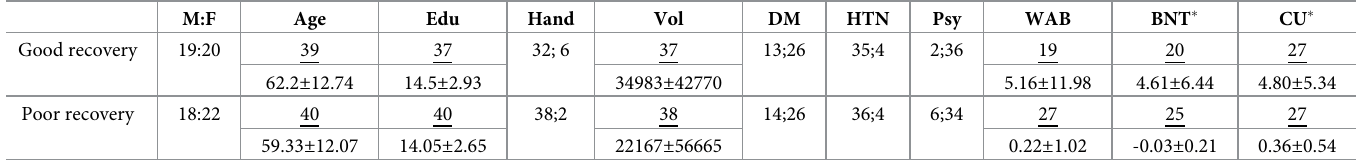
Table 3. Demographic and performance summary by recovery group.